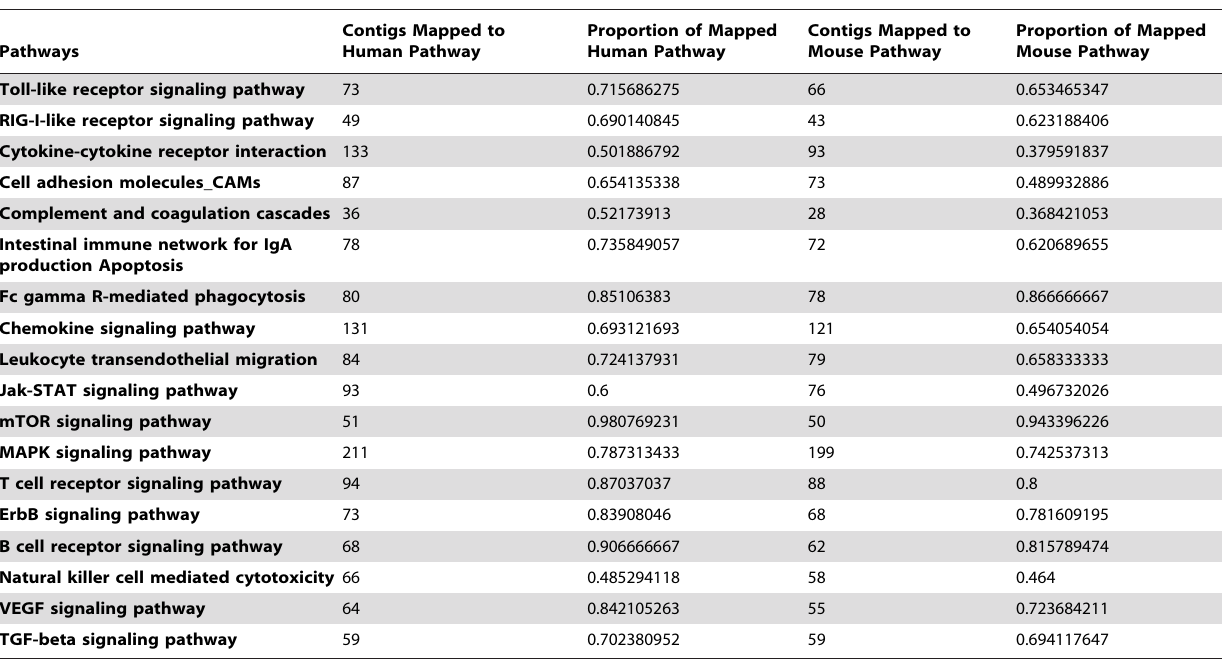
Table 2. Comprehensively mapped genes on the KEGG